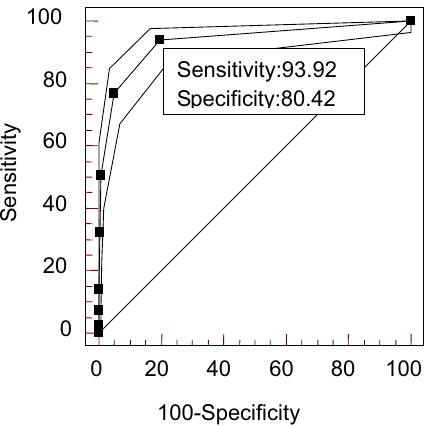
Figure 2. ROC curve analysis for the number of positive-AAbs. AAbs